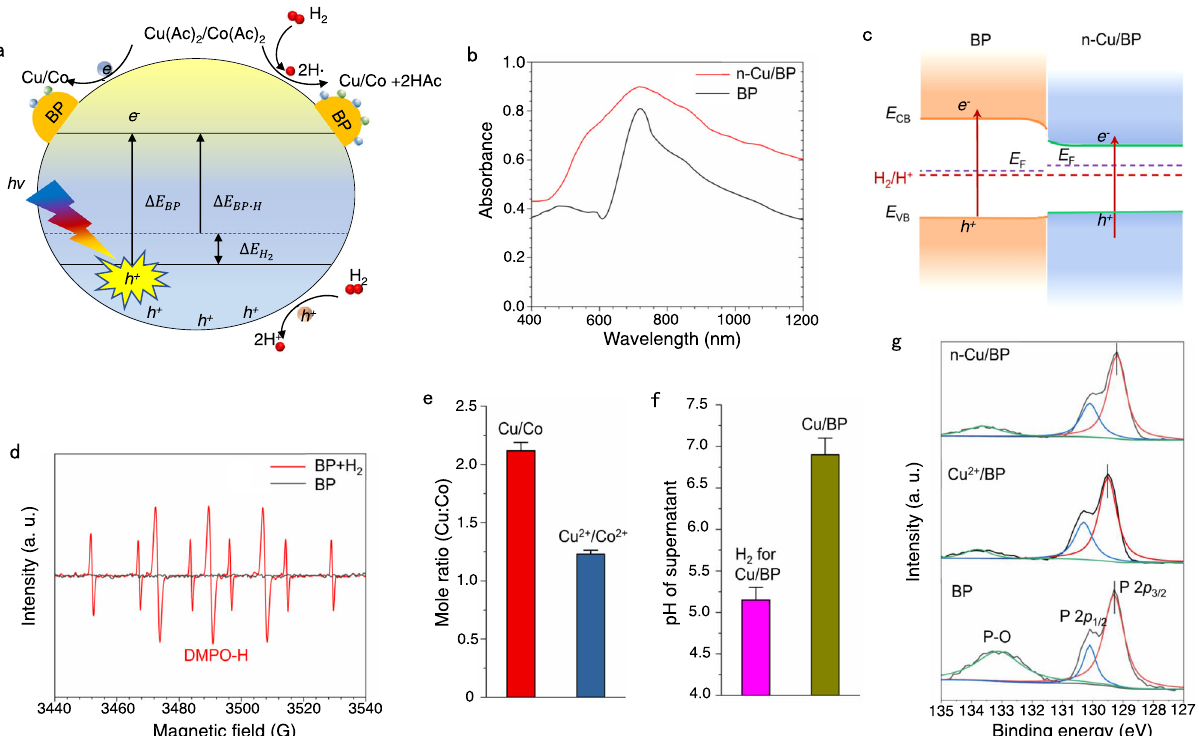
Fig.3|Fundamentalunderstandingofthesynthesisprocessofelectrocatalyst. a Schematic diagram of photochemical induced M/BP synthesis. b UV/Vis DRS spectra. c EnergydiagramofBPandn-Cu/BP,respectively)( E F respectsFermilevel). d ESR spectraofthesolutions obtained after150s of visible-light-induced reaction